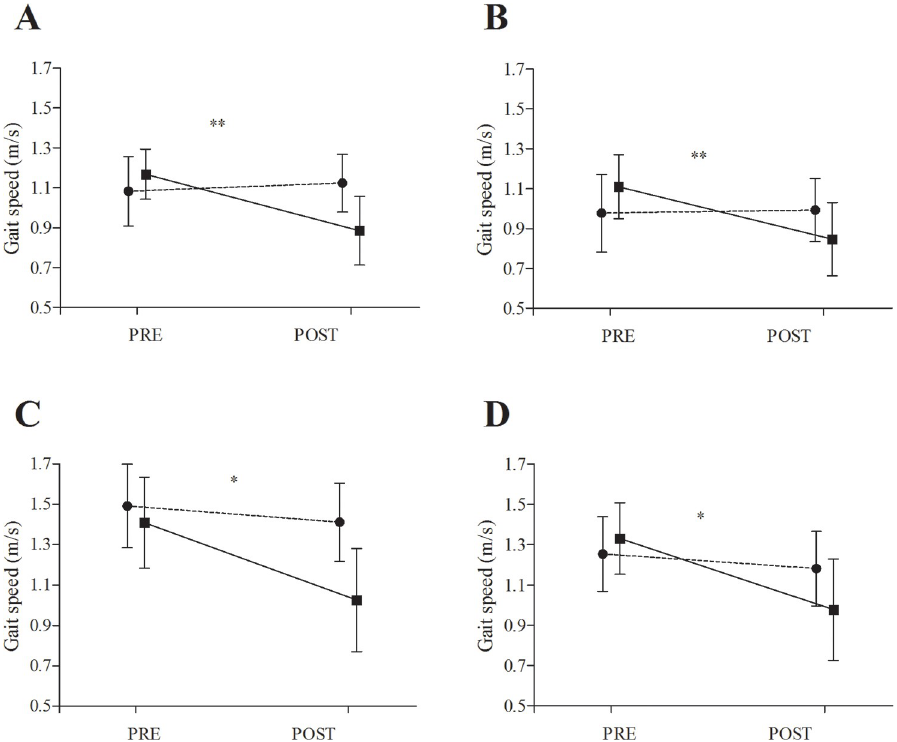
Fig 2. Illustration showing gait speed results during walking in: a) self-selected pace under single-task condition; b) self-selected pace under dual-task condition; c) brisk-pace under single-task condition and d) brisk-pace under dual-task condition. Data are presented as means and standard deviations. � indicates a significant change of p < 0.05; �� indicates a significant change of p < 0.01 from PRE to POST, respectively.